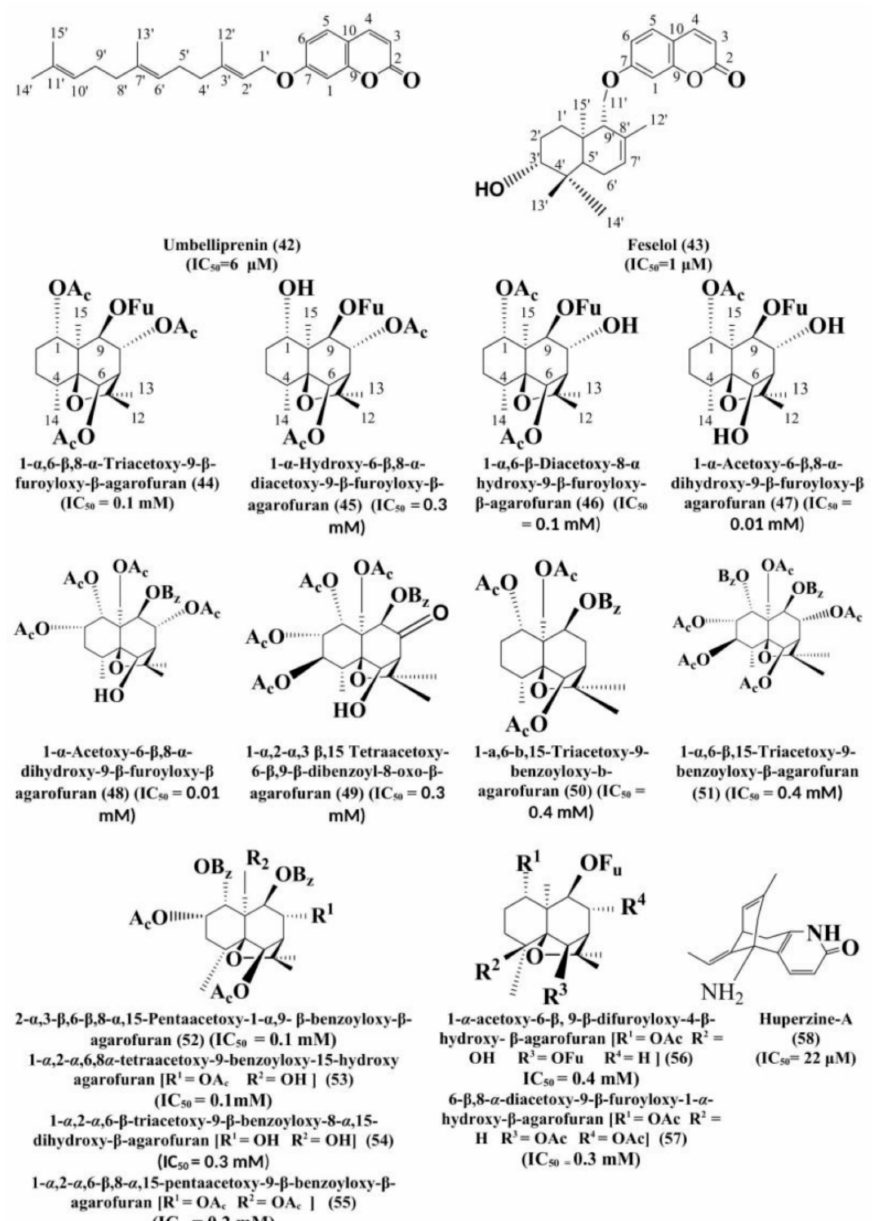
Figure 4. Structure of miscellaneous sesquiterpenes found effective against